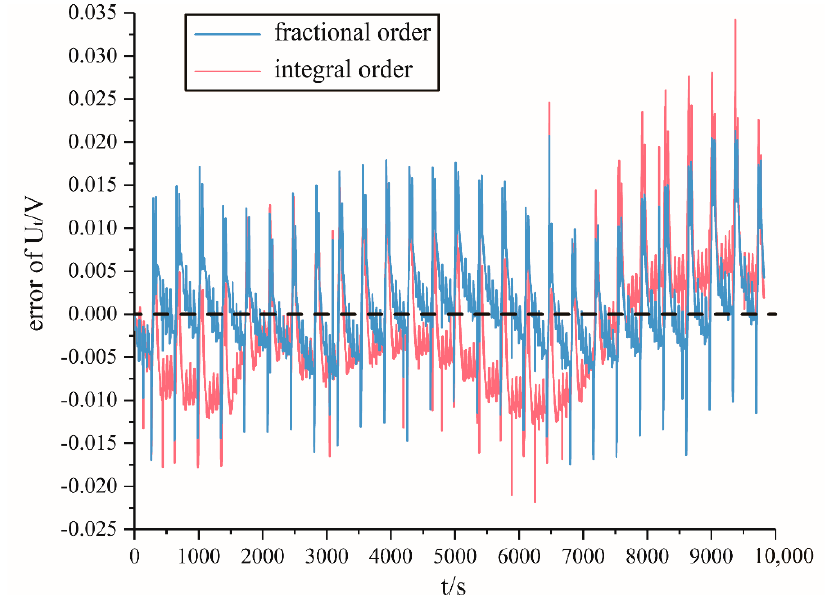
Figure 20. Comparison of terminal voltage errors between FEKF and EKF under 26 continuous DST conditions at 28 °C.